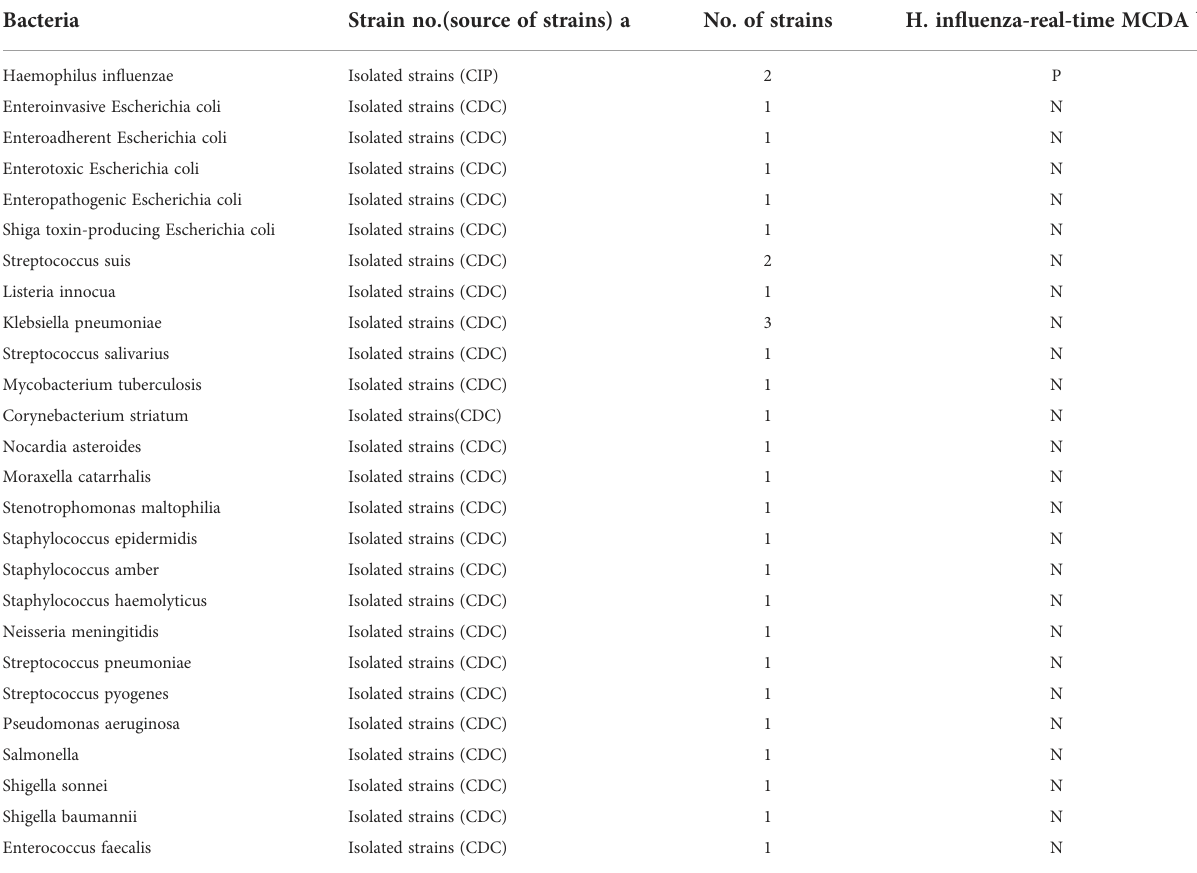
TABLE 2 Bacterial strains used to determine the speci fi city of LAMP.